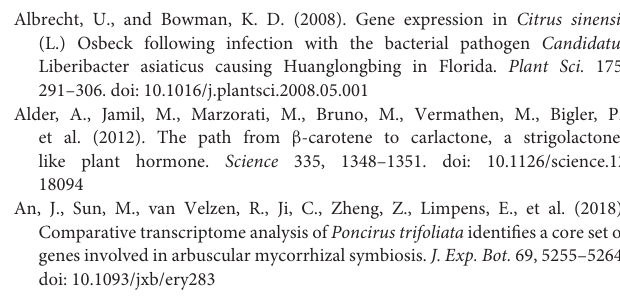
Supplementary Table 2 | DEGs of Clas-infected barks and healthy barks. Supplementary Table 3 | DEGs of Clas-infected leaves and healthy leaves. Supplementary Table 4 | DEGs of Clas-infected roots and healthy roots. Supplementary Table 5 | KEGG pathway enrichment of DEGs between Clas-infected and healthy barks. Supplementary Table 6 | KEGG pathway enrichment of DEGs between Clas-infected and healthy leaves. Supplementary Table 7 | KEGG pathway enrichment of DEGs between Clas-infected and healthy roots. Supplementary Table 8 | KEGG pathway enrichment of DAMs between Clas-infected and healthy barks. Supplementary Table 9 | KEGG pathway enrichment of DAMs between Clas-infected and healthy leaves. Supplementary Table 10 | KEGG pathway enrichment of DAMs between Clas-infected and healthy roots. Supplementary Table 11 | The 56 Common KEGG pathways enriched by DAMs and DEGs in bark. Supplementary Table 12 | The 54 common KEGG pathways enriched by DAMs and DEGs in leaf. Supplementary Table 13 | The 45 common KEGG pathways enriched by DAMs and DEGs in root.